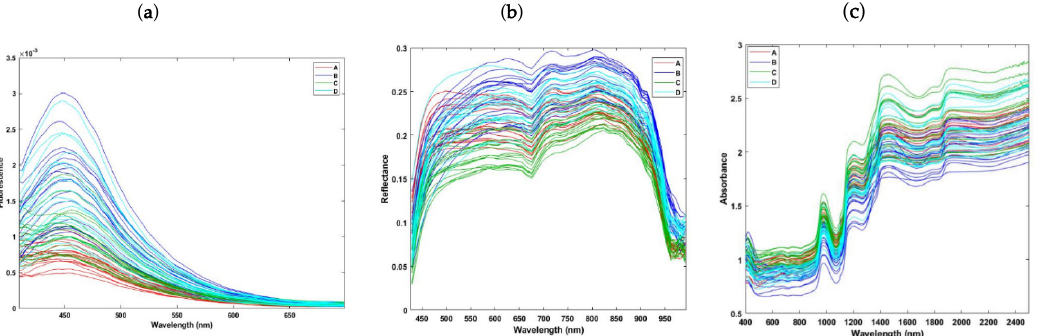
Figure 2. Raw spectra from online fluorescence (a) and diffuse reflectance (b) hyperspectral imaging, and offline visible/near diffuse reflectance infrared (c) measurements of the four lutefisk